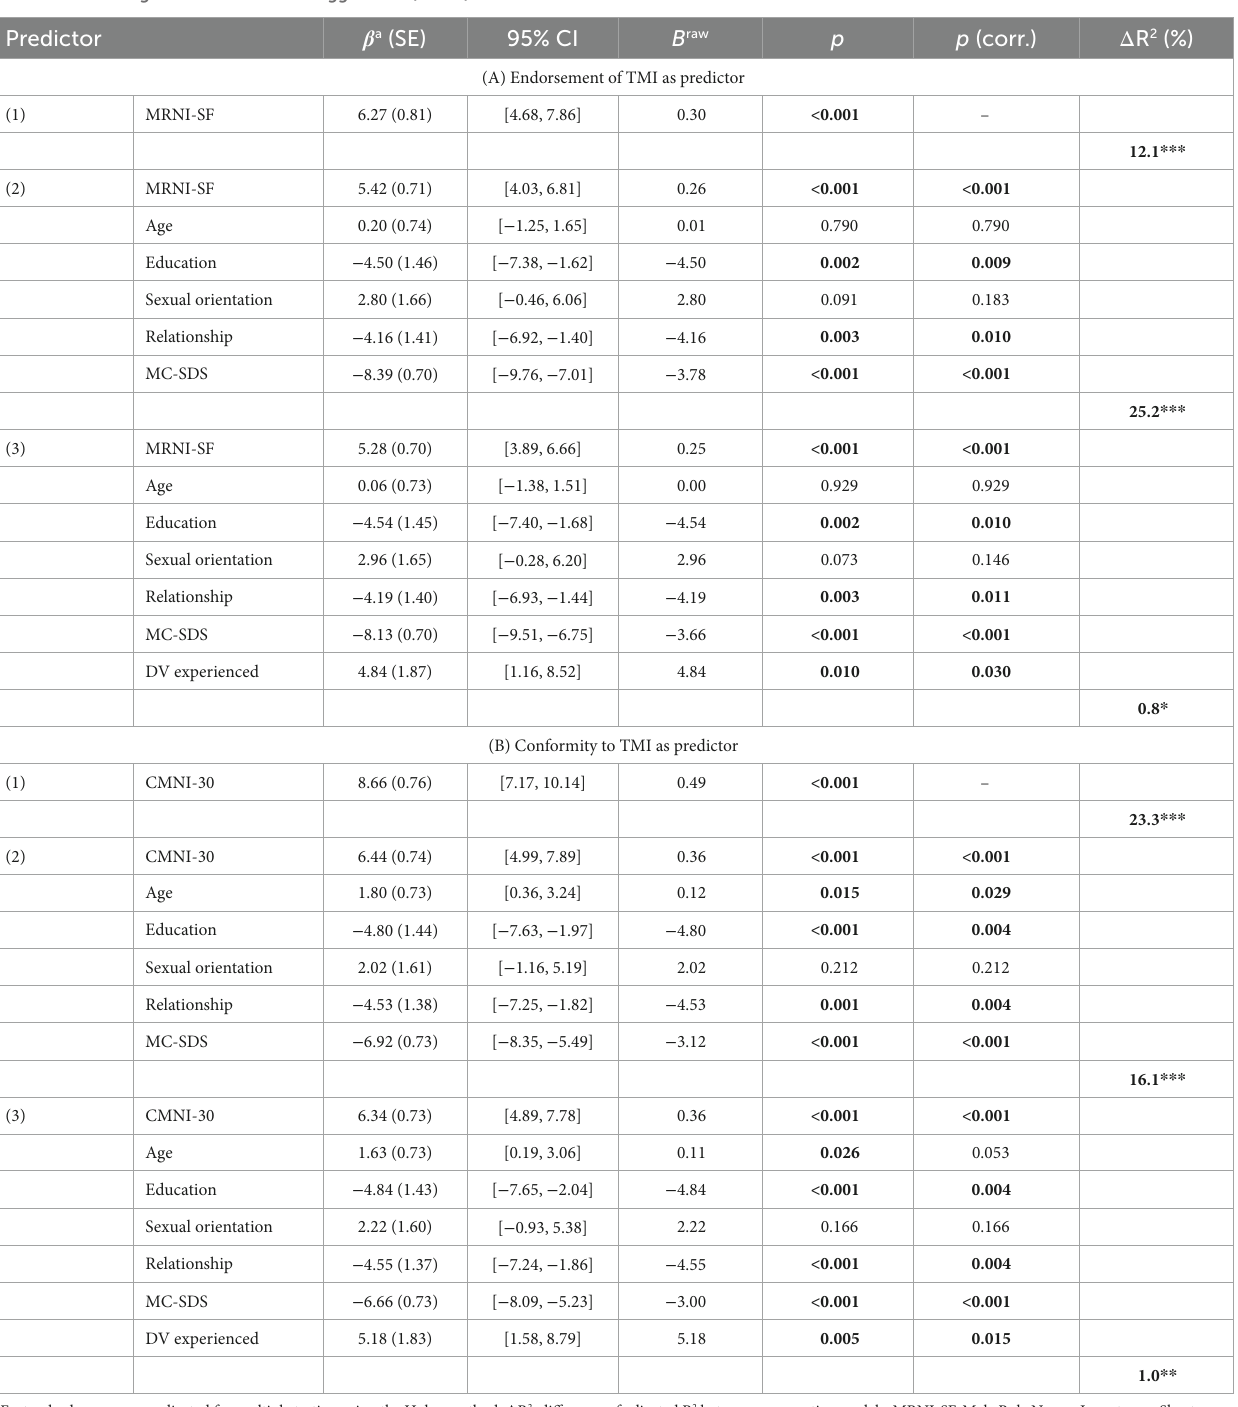
TABLE 3 Linear regression models with aggression (ABPQ) as outcome variable.